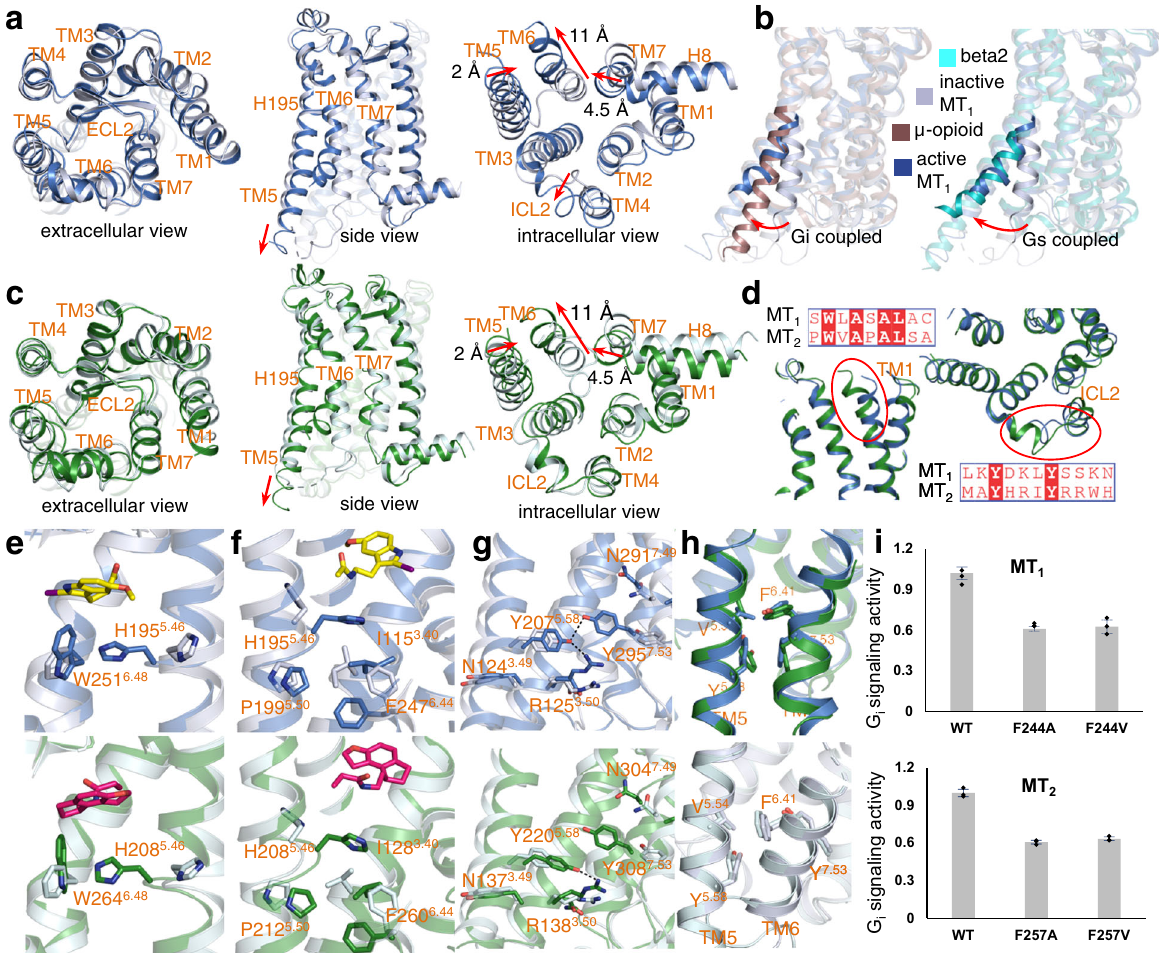
Fig. 3 MT 1 and MT 2 activation. a Structural comparison of the active (blue) and inactive (light blue) MT 1 . Three views are presented. b Comparison of the conformation of TM6 from MT 1 with that from the G i -coupled receptor μ -opioid (left, PDB ID: 6DDE) receptor and G s -coupled receptor beta2 (right, PDB ID: 3SN6). c Structural comparison of active (green) and inactive (light green) MT 2 . Three views are presented. d Comparison of TM1 (left) and ICL2 (right) from MT 1 and MT 2 . e – g Conformational changes of the key residues and motifs during receptor activation in MT 1 (above) and MT 2 (below). h The conformations of F 6.41 in active (above) and inactive (below) MT 1 and MT 2 structures. i The Gi signaling ability of the F 6.41 mutant of MT 1 and MT 2 . Data were normalized to that of the wild-type receptor and presented as the means ± standard error of three